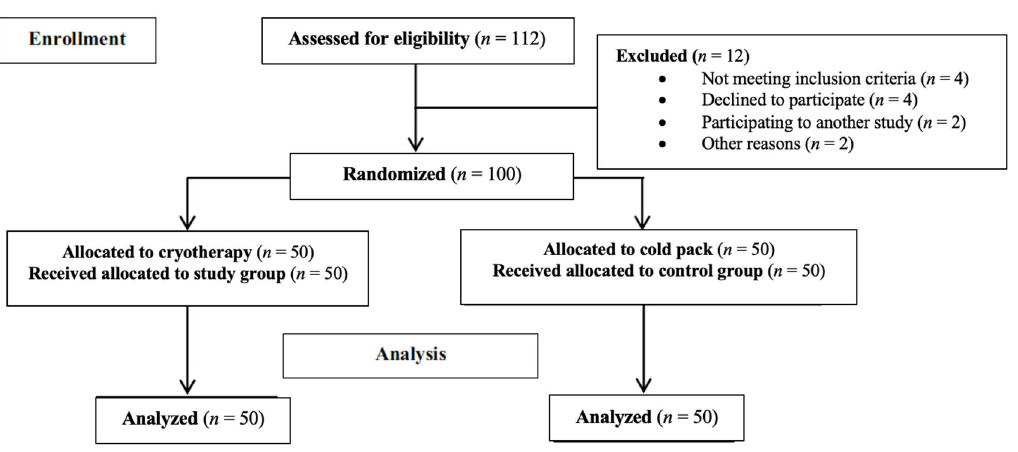
Figure 2. Diagram of the number of patients enrolled and analyzed in this study using STROBE guidelines.